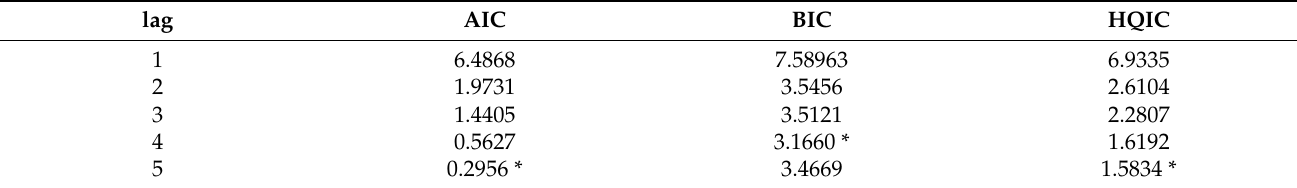
Table 3. Panel VAR lag order